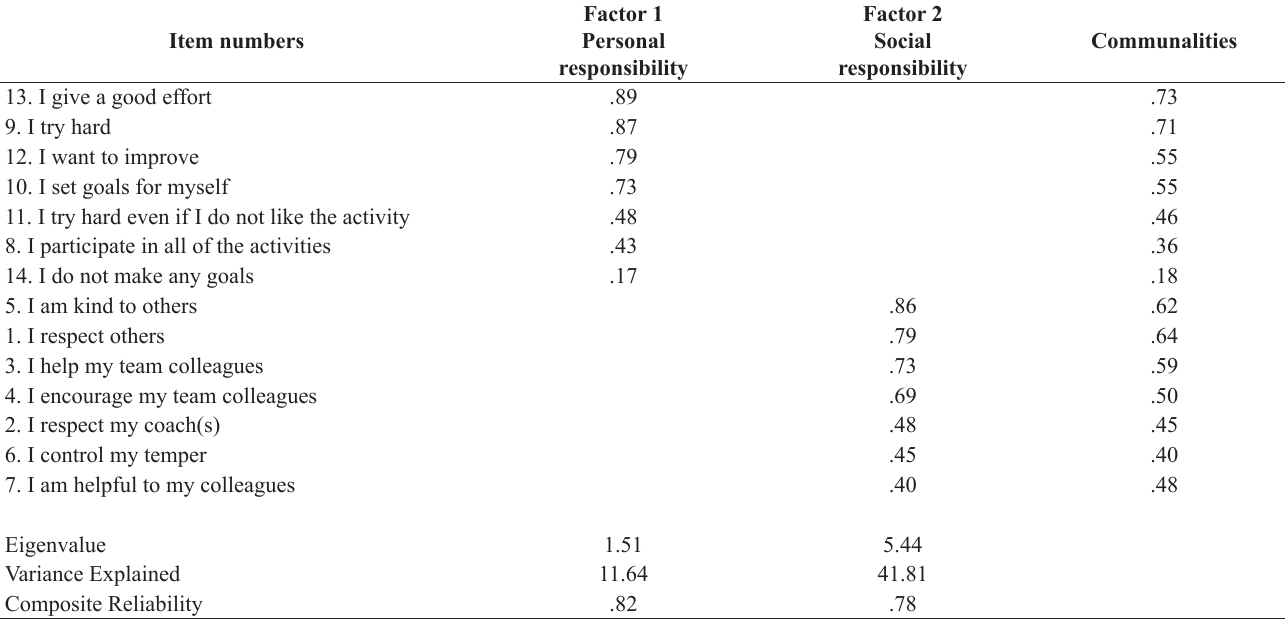
Table 1. Summary results for Exploratory Analysis of the PSRQ.